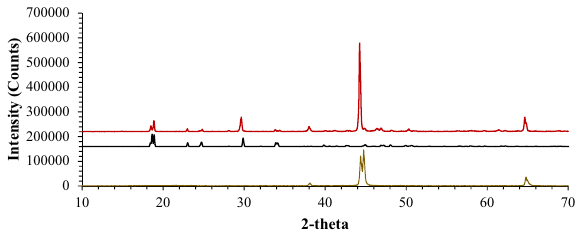
Fig. 4 X-ray diffractogram of the surface of the coupon from the biotic experiment with oxalate. X-ray diffractogram of the surface of the coupon is indicated by the red top line. The X-ray diffractograms of humboldtine (FeC 2 O 4 ·2H 2 O) (black middle line) and C1018 steel (yellow bottom line) are provided for reference.